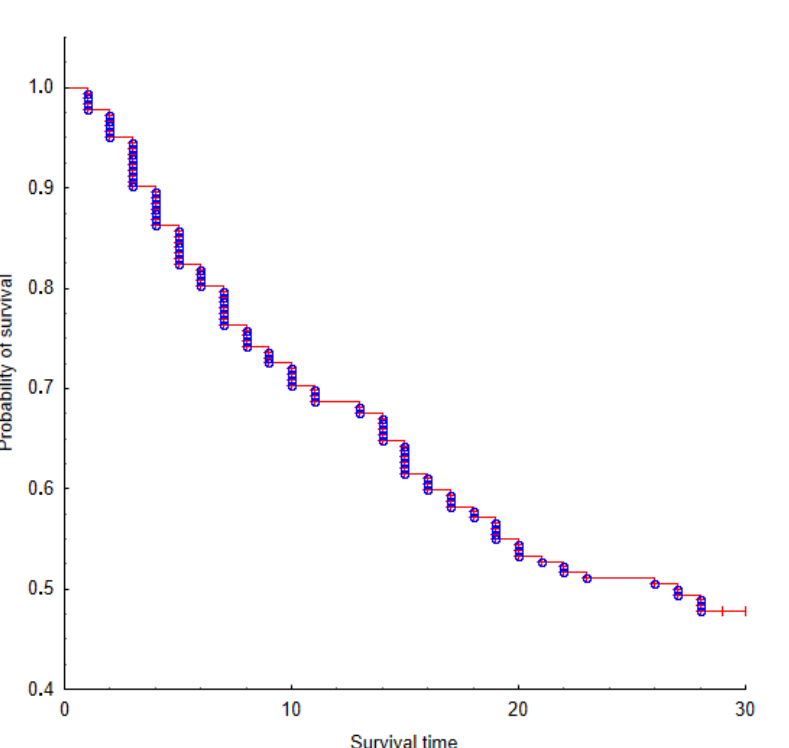
Figure 6. The Kaplan-Meier survival model for one group of divisional and non-divisional variables over a period of one